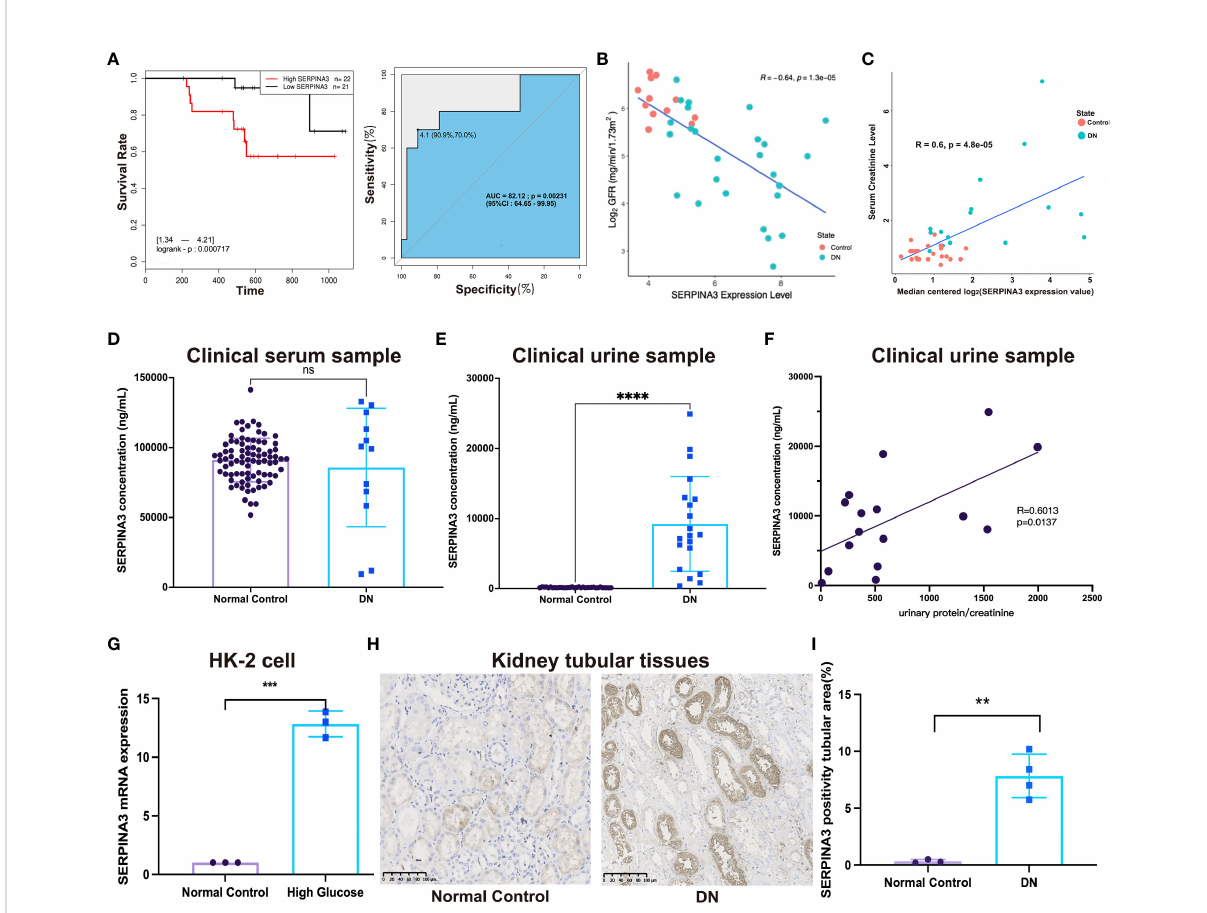
FIGURE 7 Validation of the relationship between SERPINA3 and DN. (A) Kaplan – Meier curve of SERPINA3 provided by dbPKD and the corresponding ROC curve. (B) Correlation between the SERPINA3 expression level and Log 2 GFR (GFR, glomerular fi ltration rate). (C) Correlation between median centered log 2 (SERPINA3 expression value) and serum creatinine levels. Both GFR and serum creatinine level data were obtained from the database Nephroseq . (D) Comparison of the concentration of SERPINA3 proteins in serum samples between patients with DN and healthy controls. (E) Comparison of the concentration of SERPINA3 proteins in urine samples between patients with DN and healthy controls. (F) Correlation between the SERPINA3 protein concentration and urinary protein/creatinine levels. (G) The relative mRNA expression level of SERPINA3 in the HK-2 cells treated/untreated with high glucose levels was measured using qPCR. (H) SERPINA3 immunohistochemical staining in kidney tubular sections from patients with DN and healthy controls. Scale bars = 25 µm. (I) Semi-quantitative analyses of the immunohistochemically stained SERPINA3- positive tubule area. **P < 0.01, ***P < 0.001, and ****P < 0.0001; ns, no signi fi